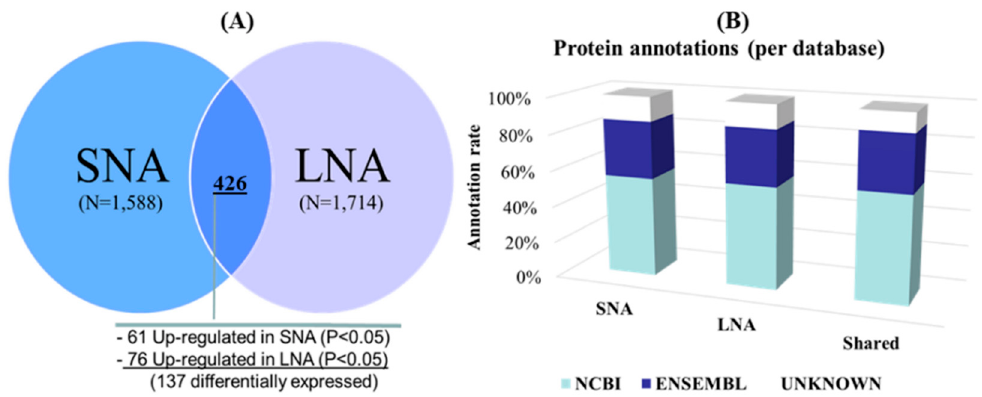
Figure 1. Total protein detection ( A ) and annotations ( B ). Venn diagram of porcine follicular fluid was constructed with tools available at the Bioinformatics and Evolutionary Genomics, Ghent, Belgium. SNA: small non-atretic; LNA: large non-atretic; NCBI: National Center for Biotechnology Information. P<0.05 indicates significant difference. Table 1. Top 10 enriched gene ontology (GO) terms up-regulated in LNA. No significant GO enrichment was found with up-regulated proteins in the SNA dataset.